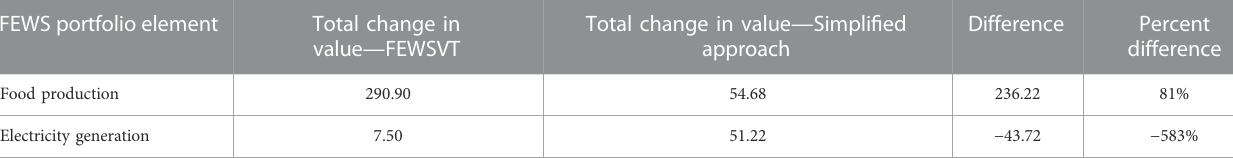
TABLE 7 Comparison of value change estimates between FEWSVT and simpli fi ed approach. FEWS portfolio